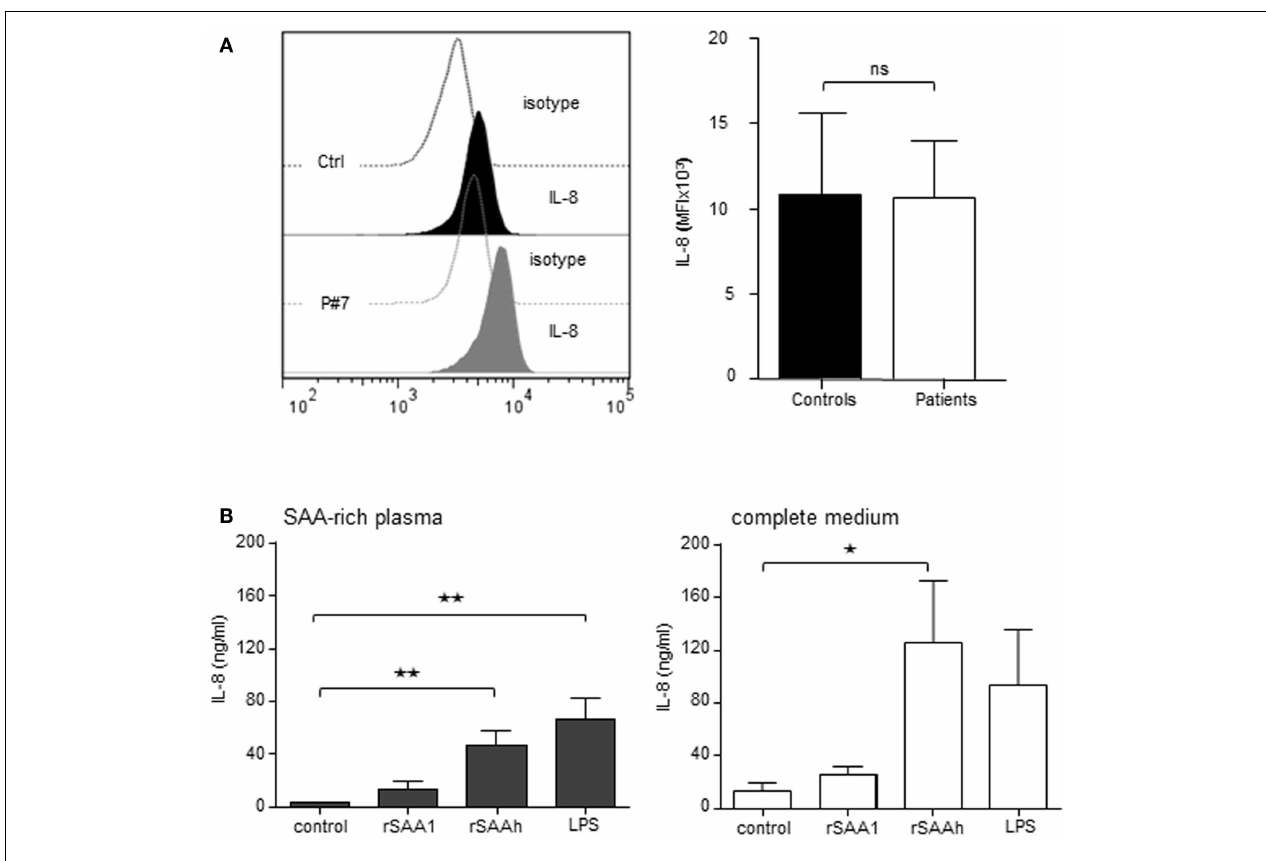
endogenous plasma (left) or complete medium; RPMI + 10% FCS and 1% PEST (right) with or without addition of rSAA1 (10 µ M), rSAAh (10 µ M), or LPS (100ng/ml).Total IL-8 content in the cultures was measured by ELISA and is shown as mean ( + SEM). Statistical analyses were performed using unpaired students t -test (A) and One-way ANOVA followed by Dunnett‘s multiple comparison test (B) . (cid:63)(cid:63) p < 0.01; ns = not